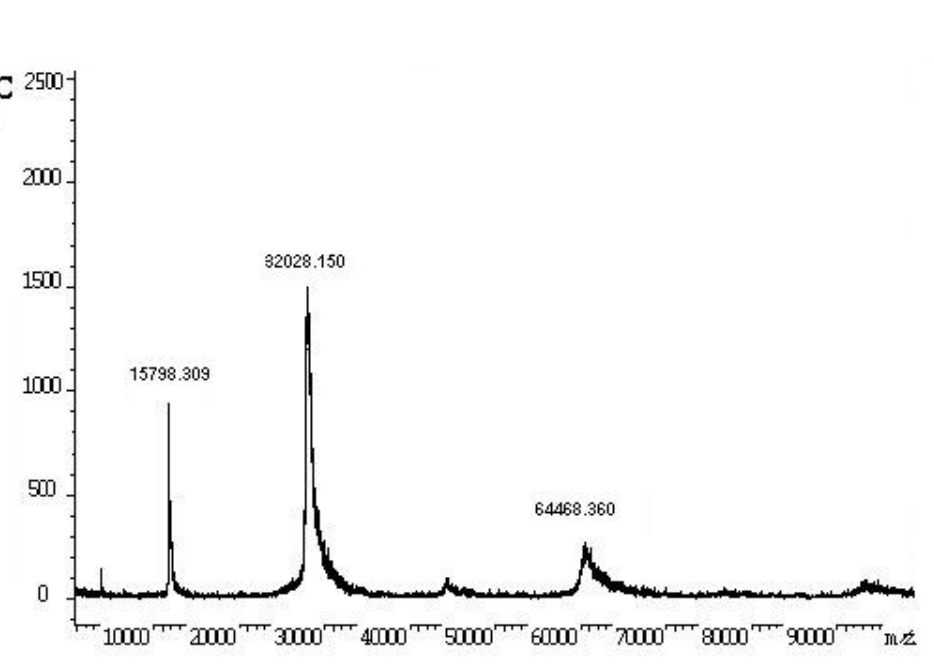
Figure 1. Lectin purification. (A) Elution profile of crude venom (100mg) on agarose-D- galactose column (5ml), collected in 2ml fractions. Total proteins were eluted with CTBS, pH 7.5, and adsorbed fraction with 100mM lactose solution in the same buffer (indicated by the arrow). (B) SDS-PAGE of the purified fraction. MM: molecular mass marker proteins (kDa); CV: Bothrops jararacussu crude venom; D: denaturant conditions in the presence of 2- mercaptoethanol; N: natural conditions. (C) MALDI-TOF mass spectrometry of B. jararacussu lectin. The sample was applied using the dry droplet technique. The spectrum was acquired in linear